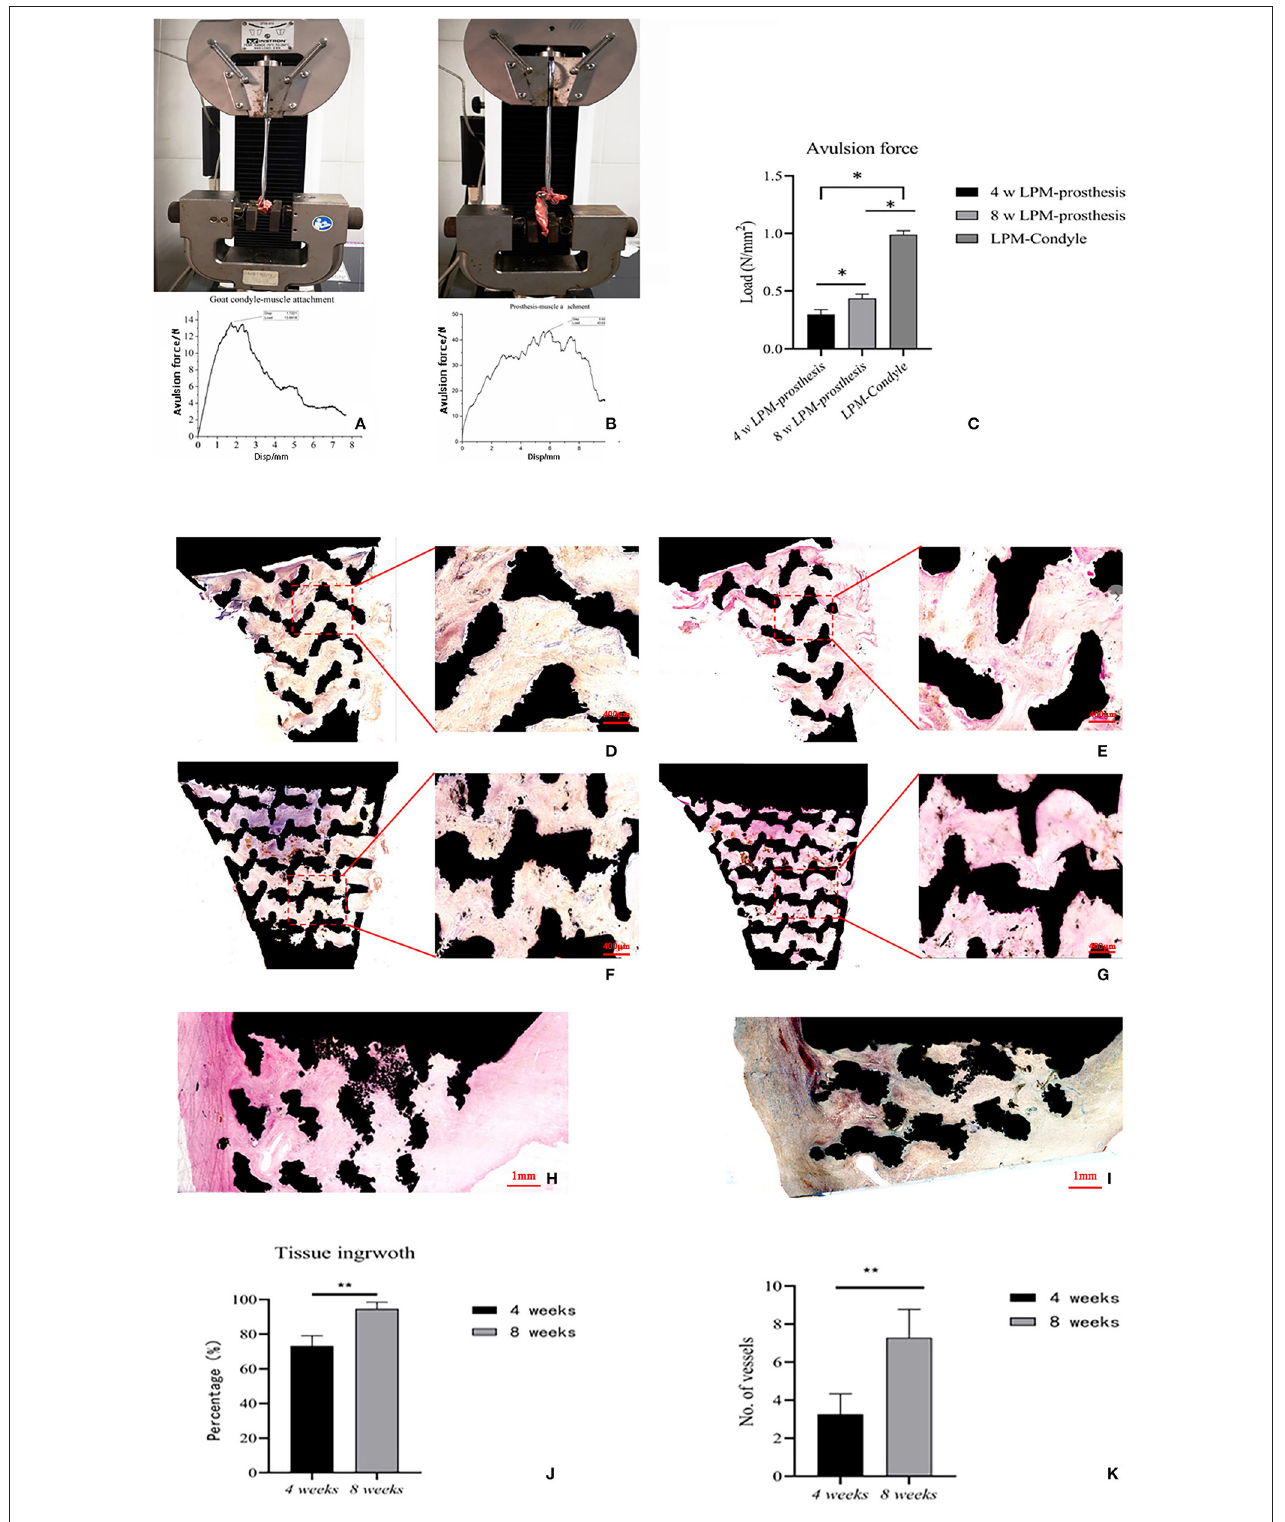
FIGURE 6 | The in-situ reconstruction of goat temporomandibular joint with porous Titanium prosthesis. (A) The avulsion force test of goat condyle-LPM. (B) The avulsion force test of prosthesis-LPM reattachment. (C) The average maximum avulsion pressure of condyle-LPM and prosthesis-LPM in both 4 and 8 weeks.